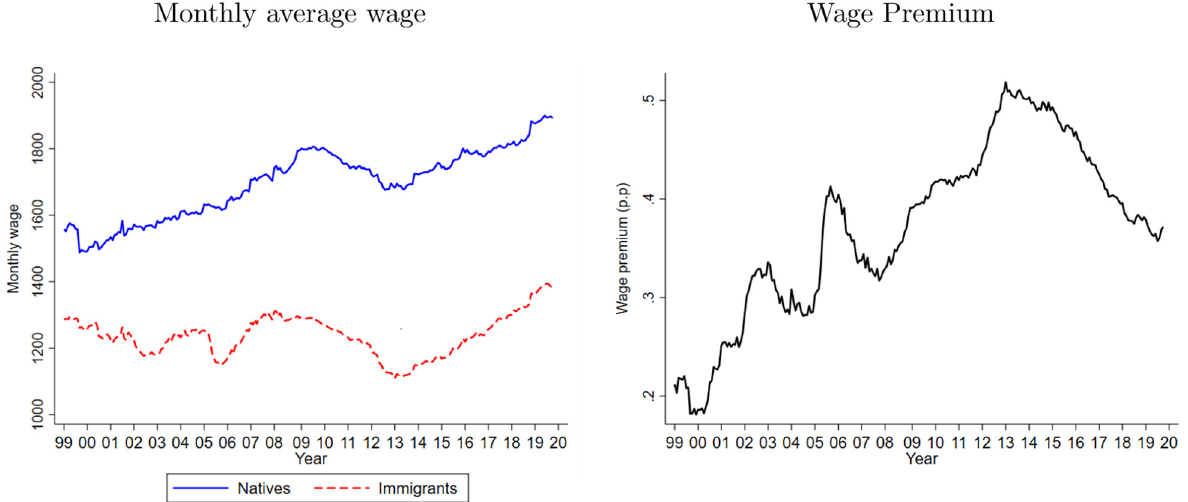
Figure 6: Monthly real wage by nationality. Note: The wage premium is computed as ( ) / w w ¯ ¯ − 1 N t M t , , , where w ¯ j t , is the monthly average wage for natives = j N and immigrants = j M at month t . Wages are seasonally adjusted by taking out the coe ffi cient of the monthly dummies from an OLS regression. Source: